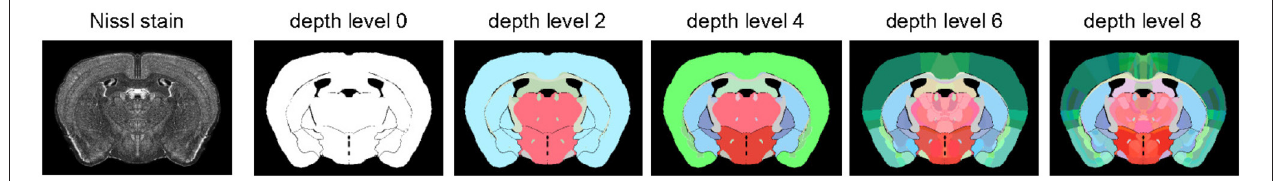
Model Dice-0 Dice-2 Dice-4